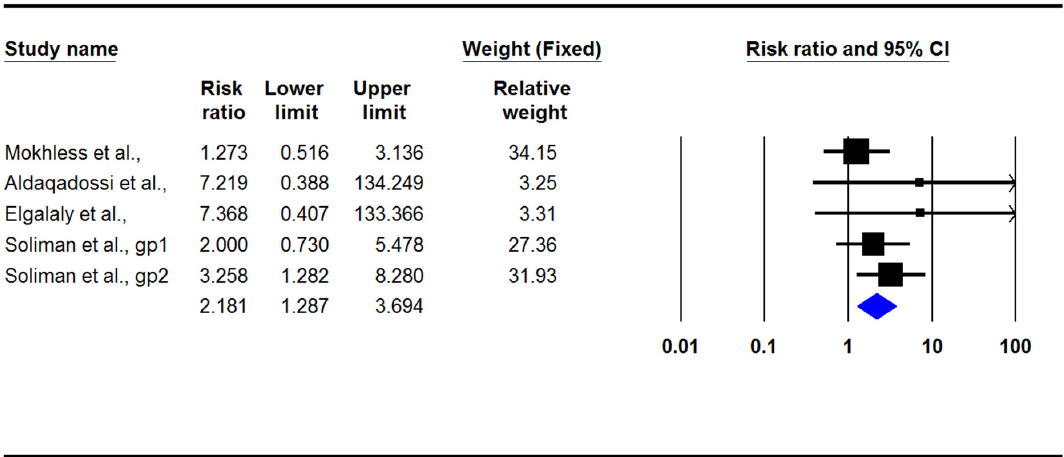
Figure 5. Forest plot for the risk ratios of adverse effects